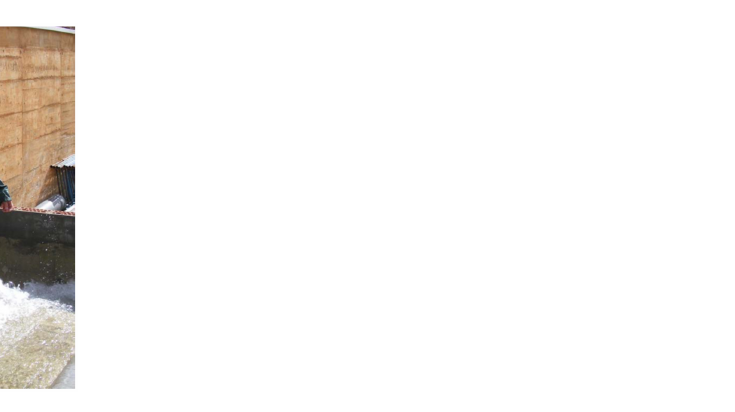
Figure 3. Tests on human stability in flooded streets carried out during the experimental campaign at the hydraulic laboratory of the Technical University of Catalonia [7].